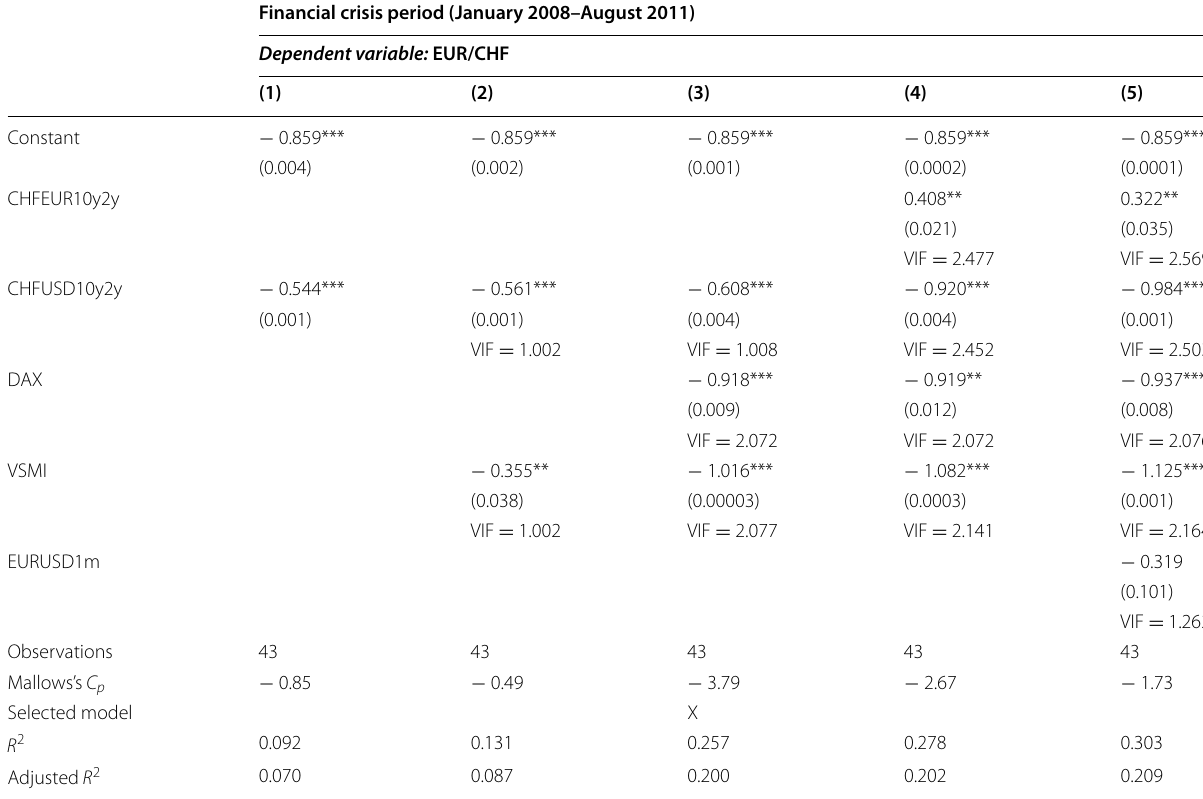
Table 3 OLS regression results for the financial crisis period (January 2008–August